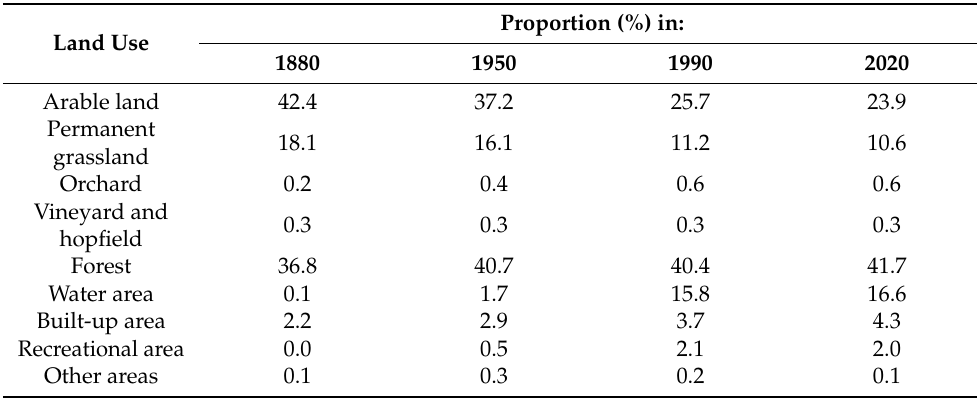
Table 2. The proportion of the land use categories in the existing water reservoirs and their surround- ings over four periods (%).